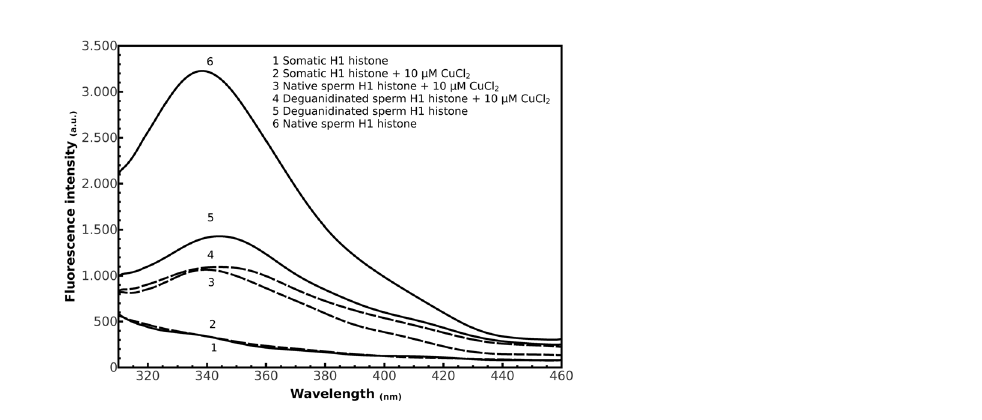
Figure 4. Plot of molar ellipticity values of H1 histones at the wavelengths of 208 (dashed line) and 222 nm (continued line) versus CuCl